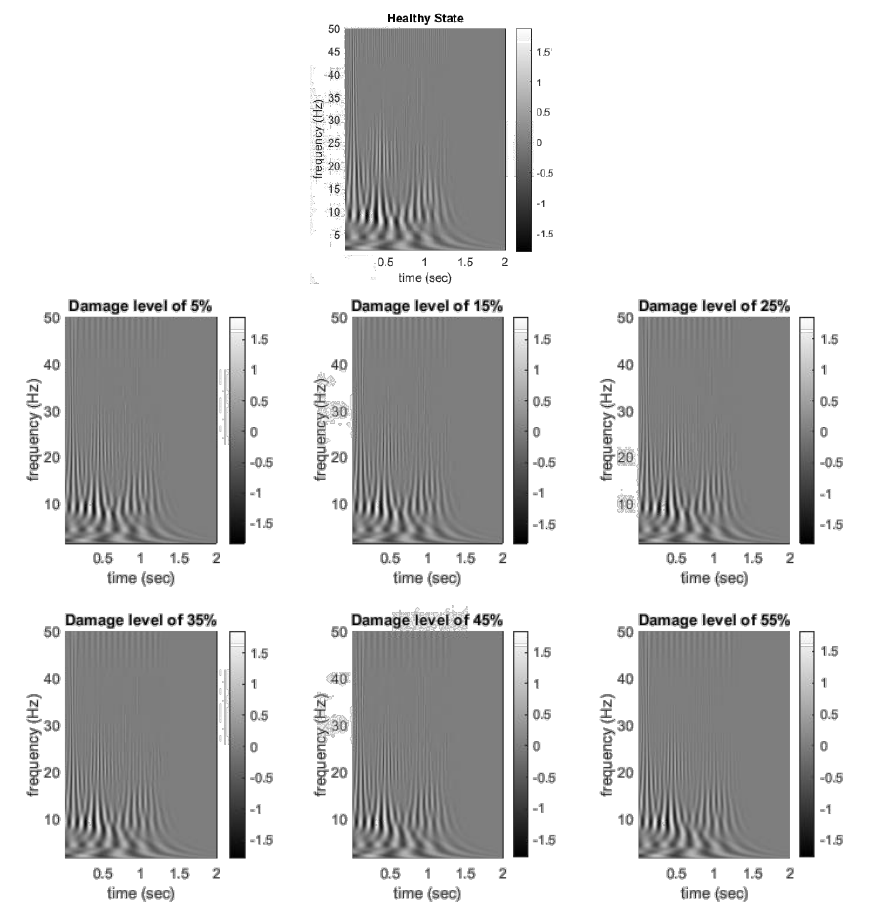
Figure 4. A sample of real-valued CWT coefficients for six damage levels and speed of 105 kph.